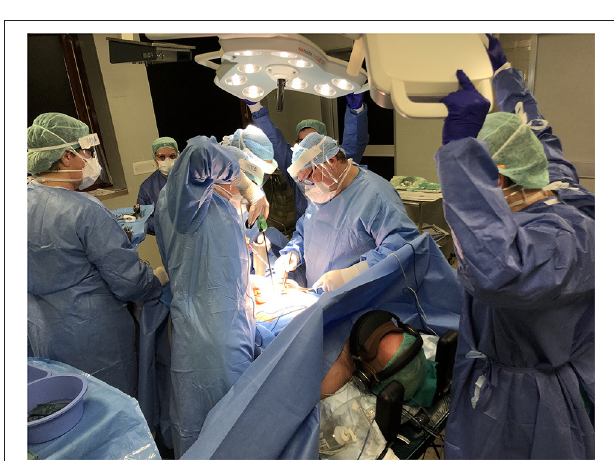
FIGURE 2 | Intraoperative use of the